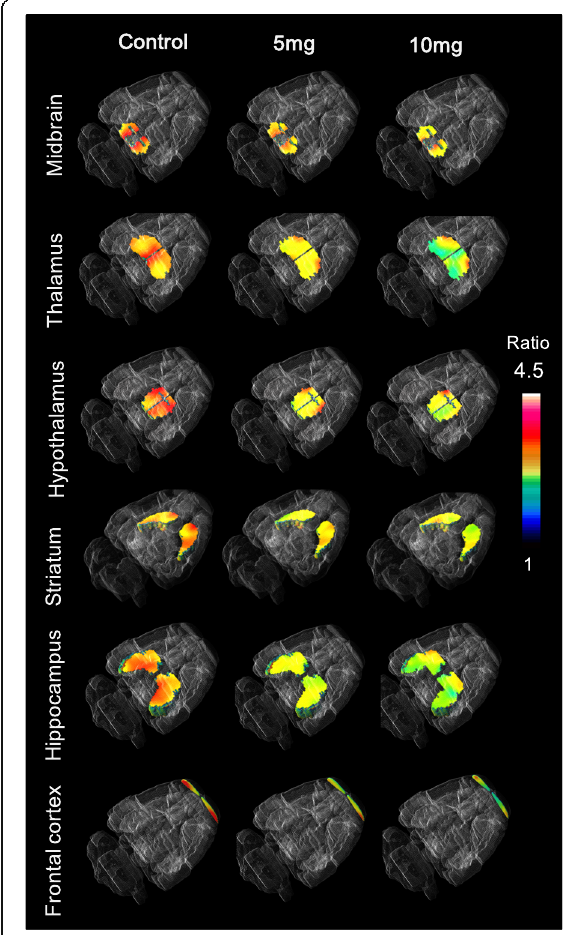
Fig. 3 3D PET parametric images showing the specific uptake ratio (SUR) of 4-[ 18 F]-ADAM in the brains of normal and methamphetamine-treated rats. The 10 mg/kg treatment group showed a globally lower 4-[ 18 F]ADAM uptake in the brain compared to the 5 mg/kg